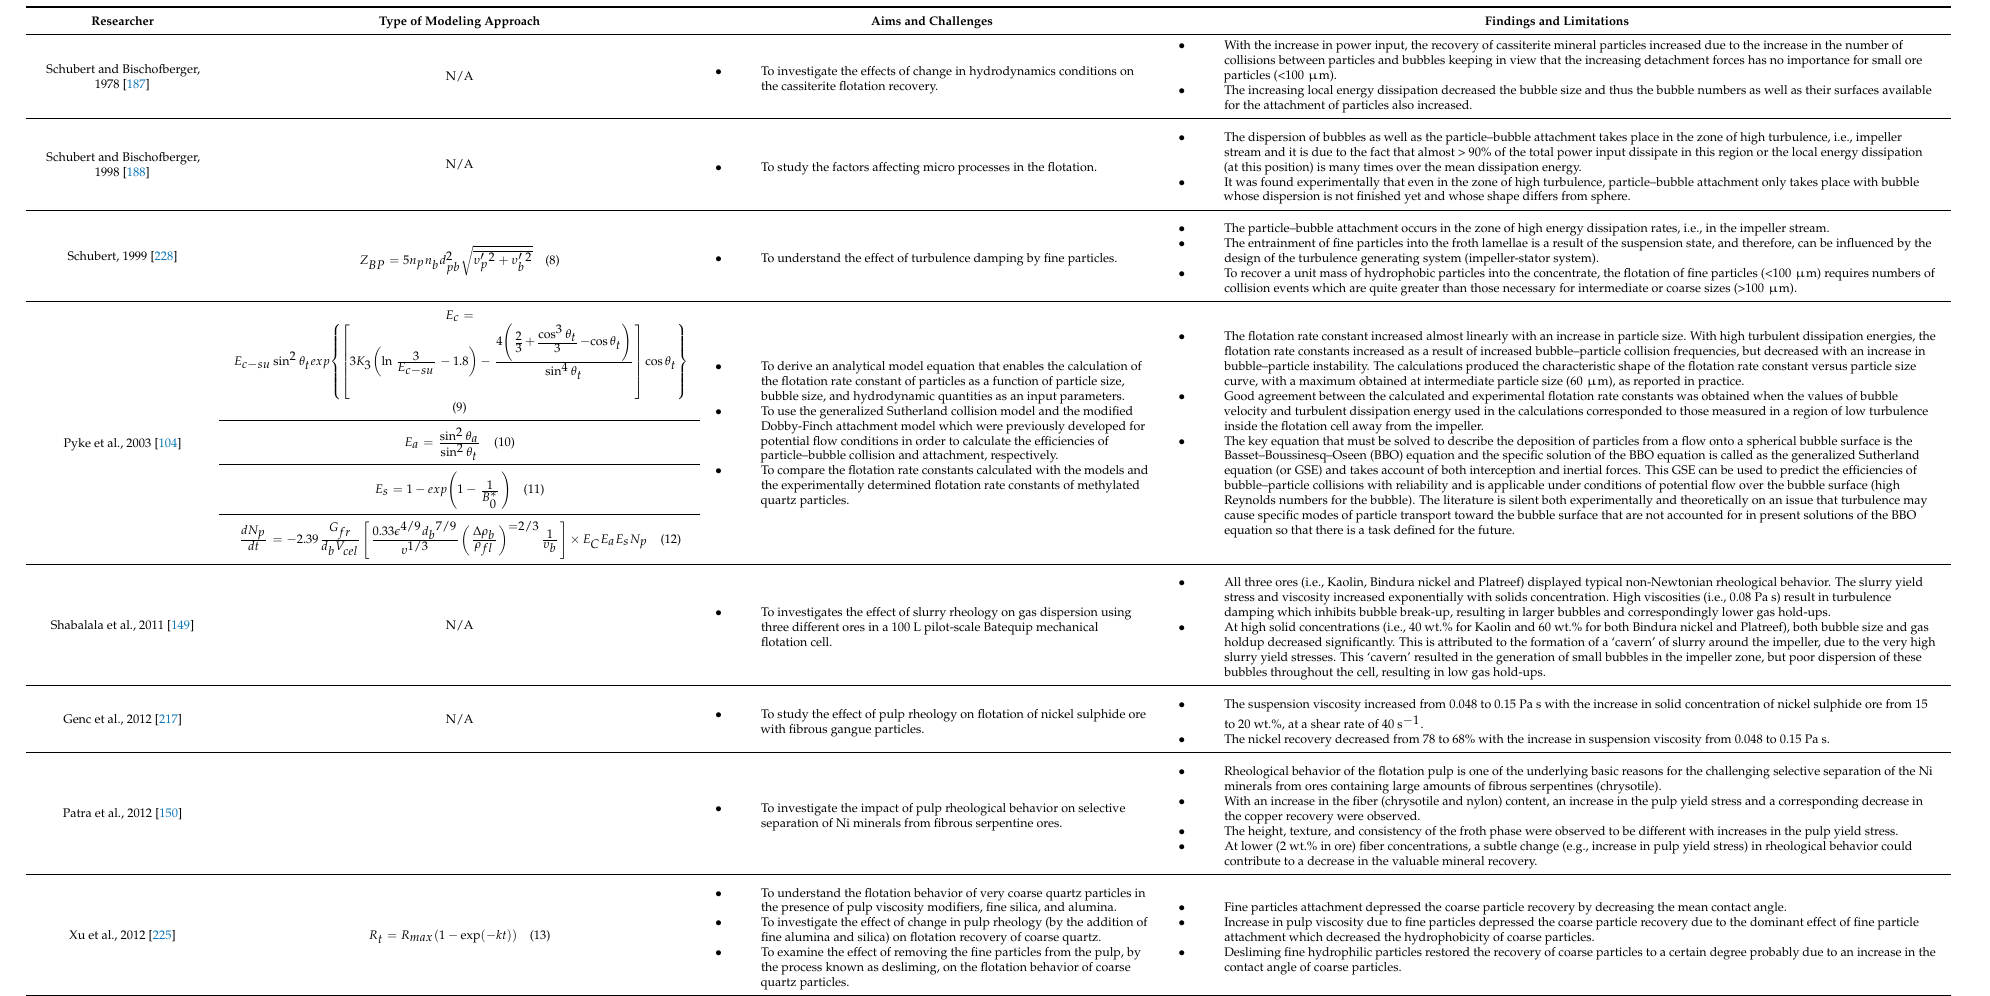
Table 2. List of previous studies discussing rheology-flotation